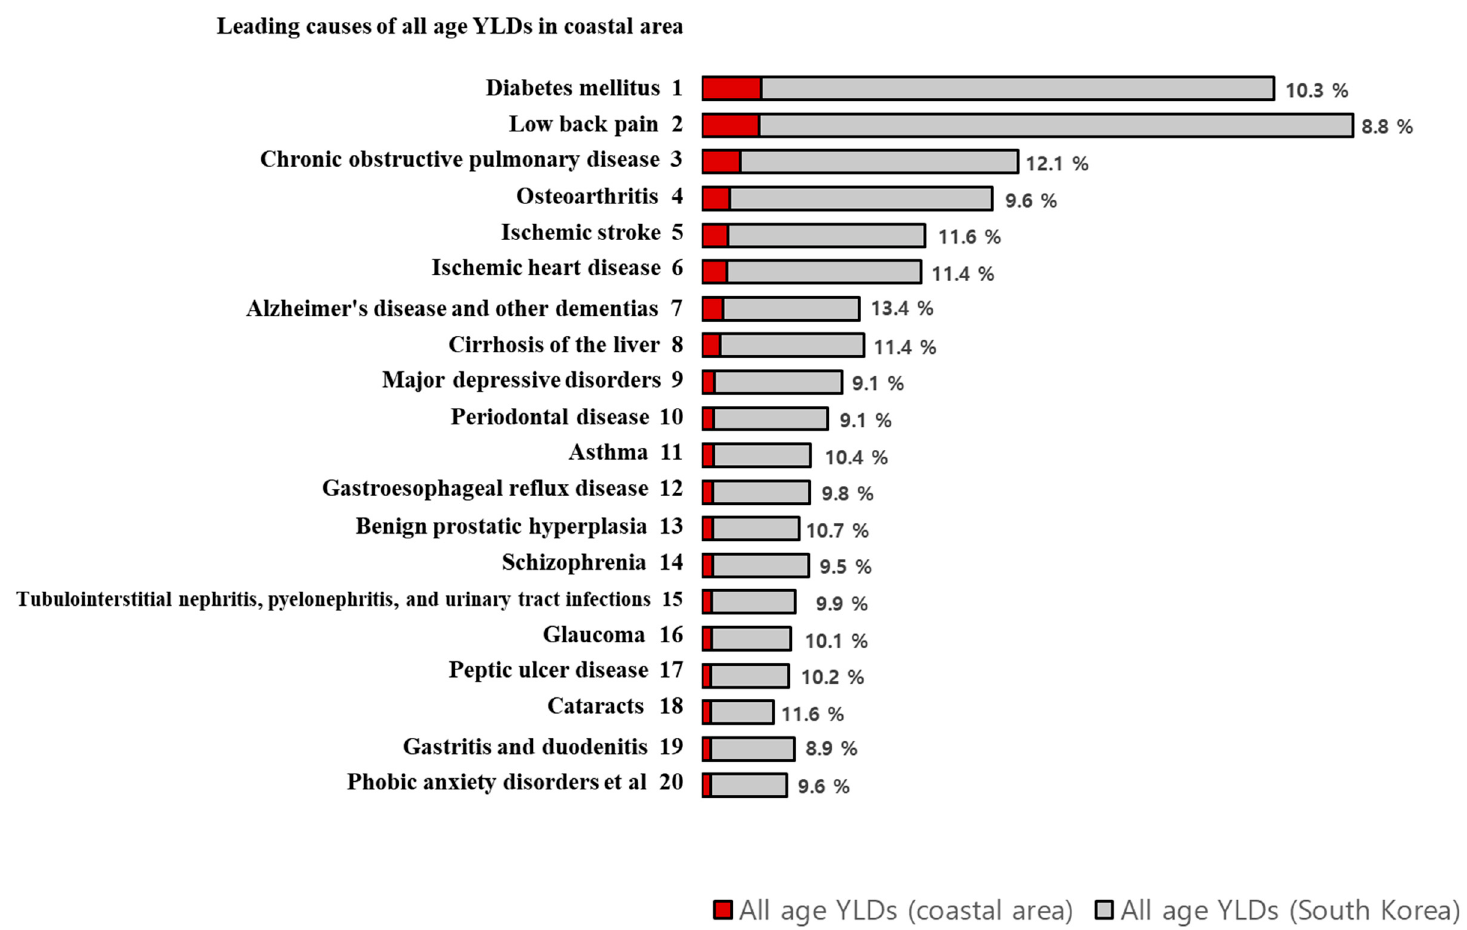
Figure 3. All age YLDs in coastal areas and in South Korea by Level 3 disease group, 2015. Abbreviations: YLDs, Years lived with disability. Data refer to the proportion of all age YLDs in the coastal areas among South Korea’s all age YLDs. Sorted by descending all age YLDs in coastal areas.